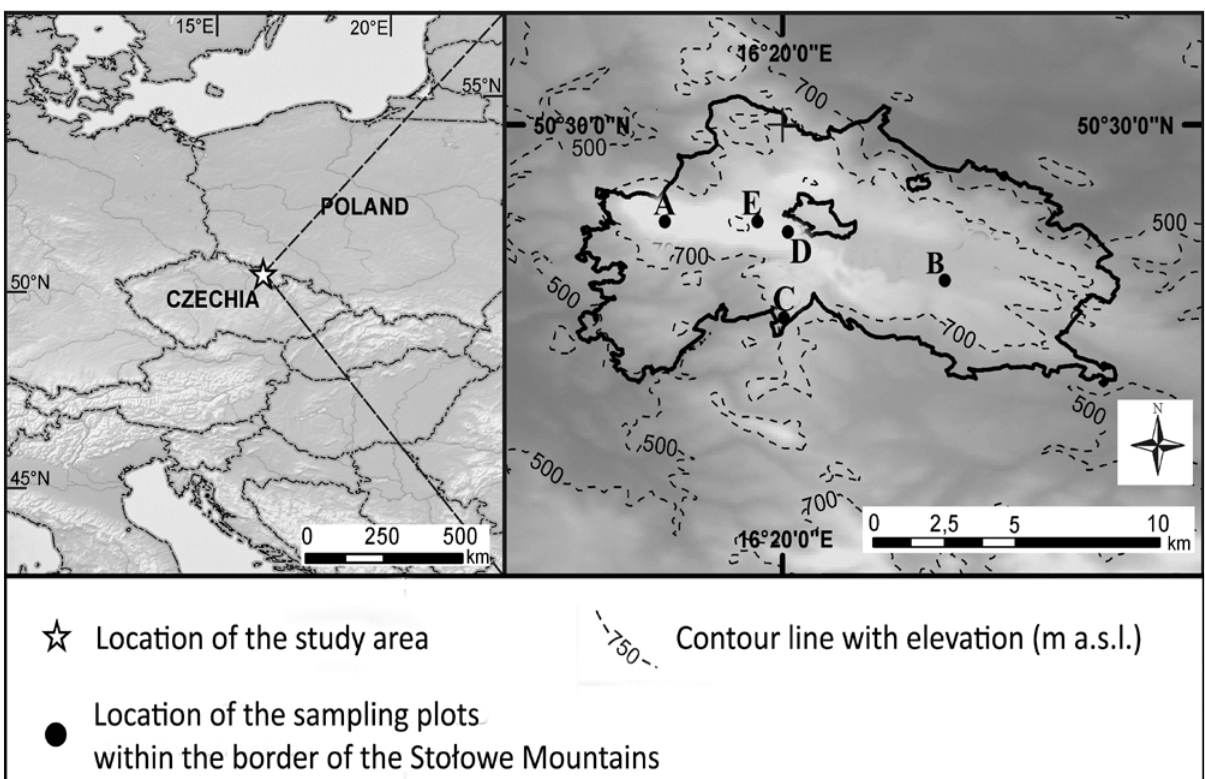
Figure 1. Location map of the study